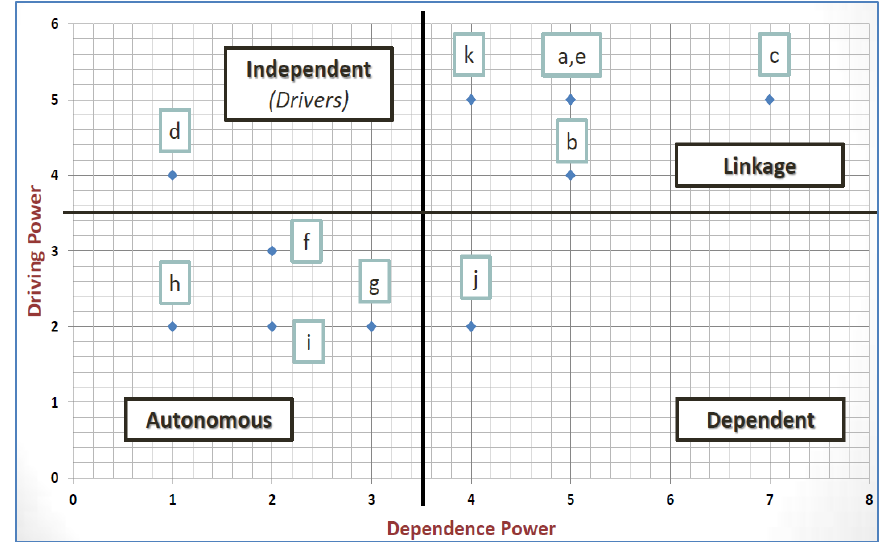
Fig. 2. Driving and Dependence Power